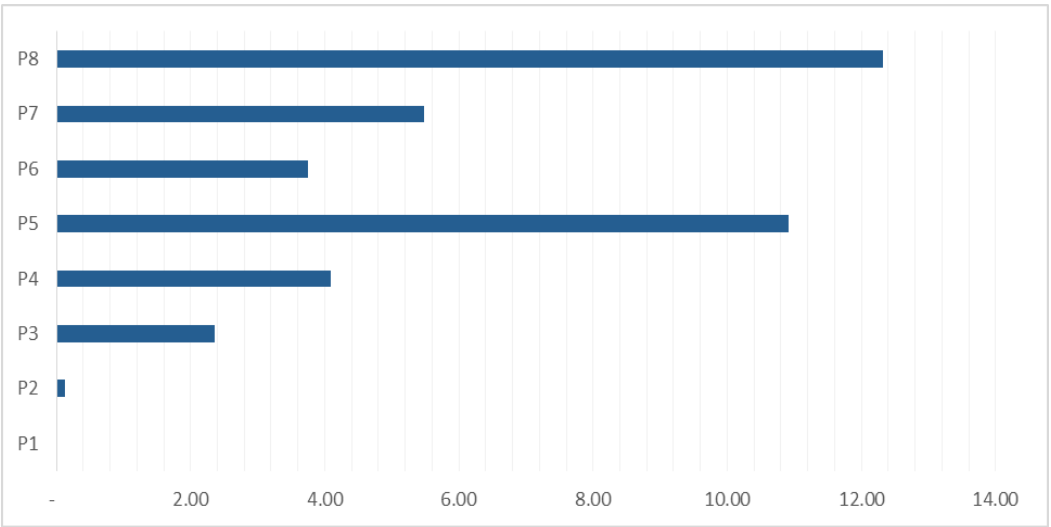
Figure 6. The removal and final disposal costs in euro/m 2 for implementing each type of project.